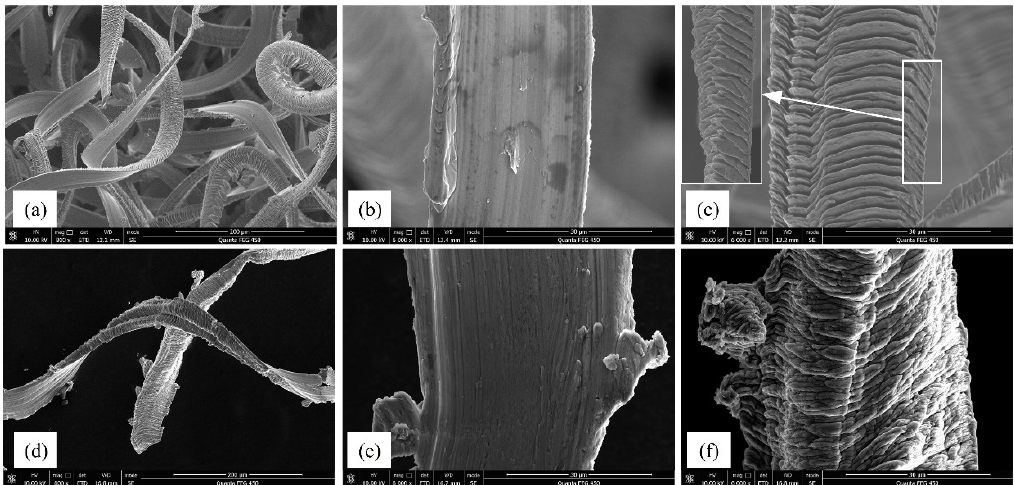
Figure 11. Chip morphology of the BMG and aluminum workpiece. ( a ) BMG macro view; ( b ) BMG back surface; ( c ) BMG free surface; ( d ) aluminum macro view; ( e ) aluminum back surface; ( f ) aluminum free surface.